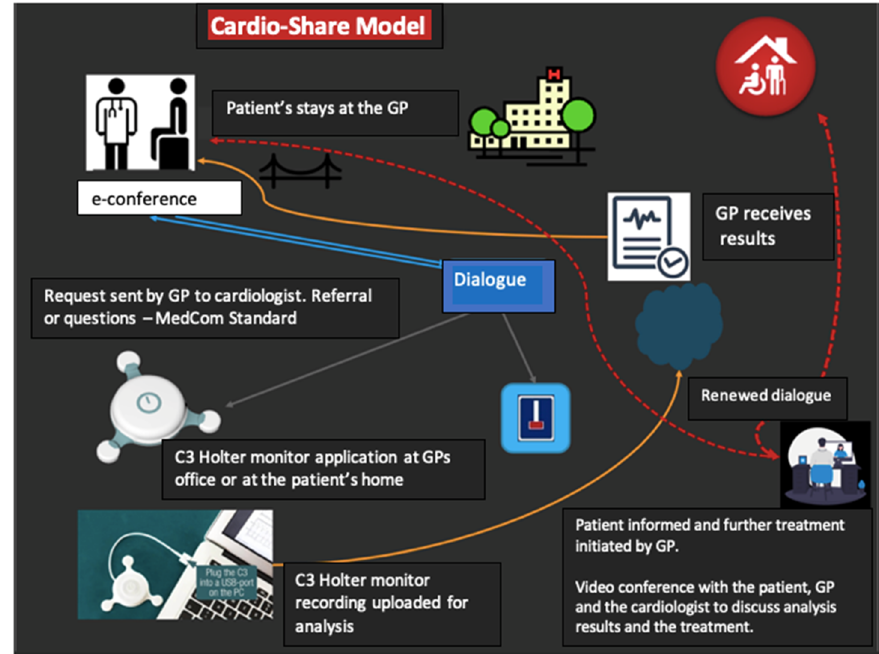
Figure 1. Cardio-Share model. “Dialogue” is exchange of messages requesting further information or clinical data. Yellow lines indicate Holter clinical data flow. Red lines indicate direct virtual communication between the cardiologists, general practitioners, and patients and their caregivers.